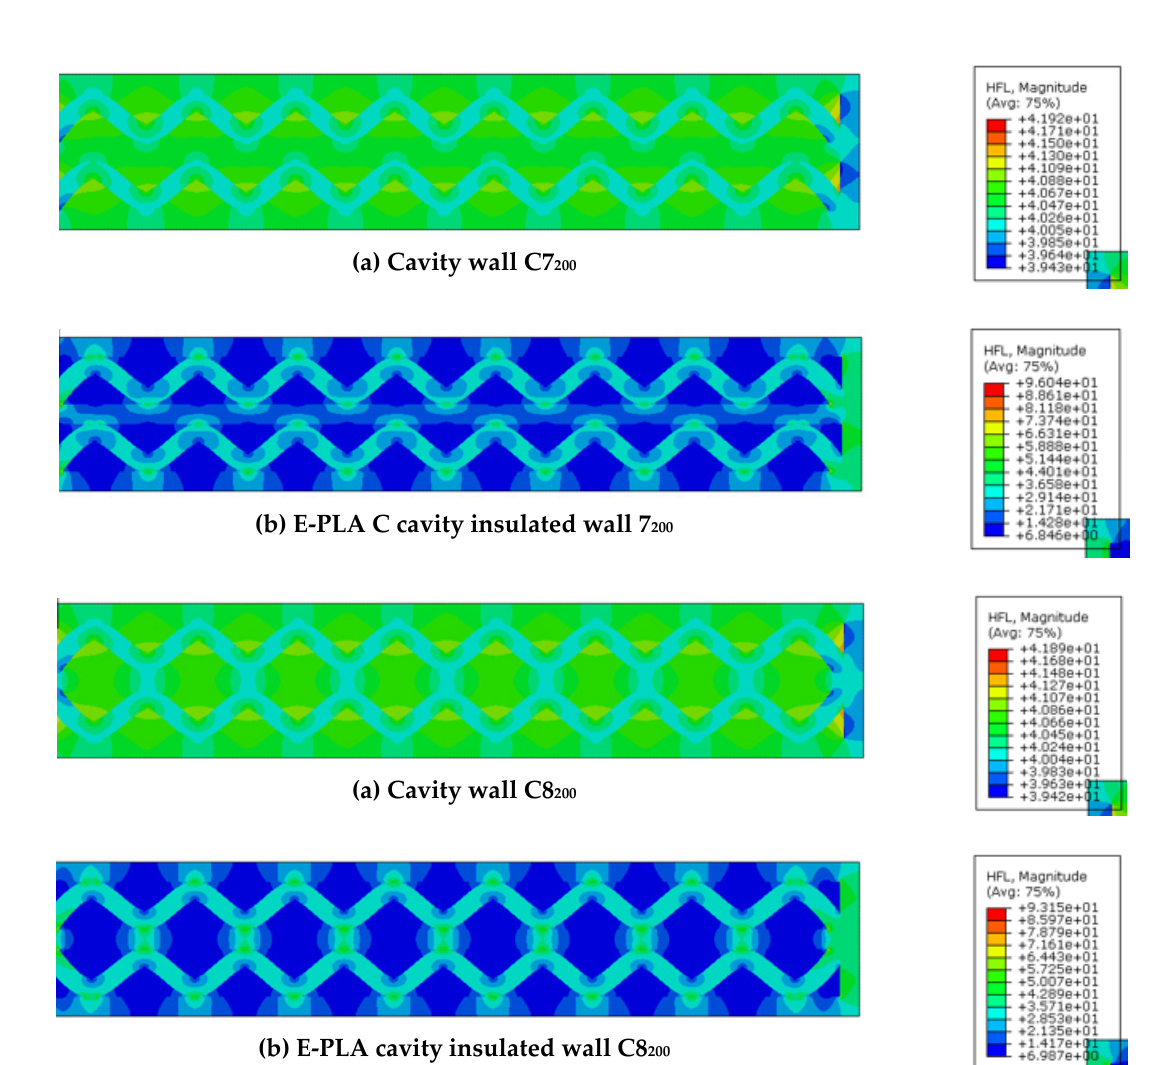
Figure 12. Heat-flux colour distribution along the 200 mm wall configurations.